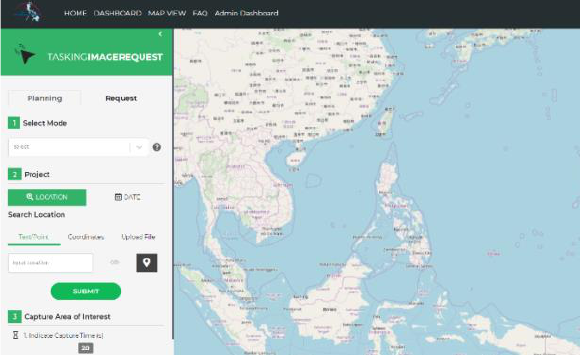
Figure 2.a. Tasking and planning module in the SIYASAT Portal.